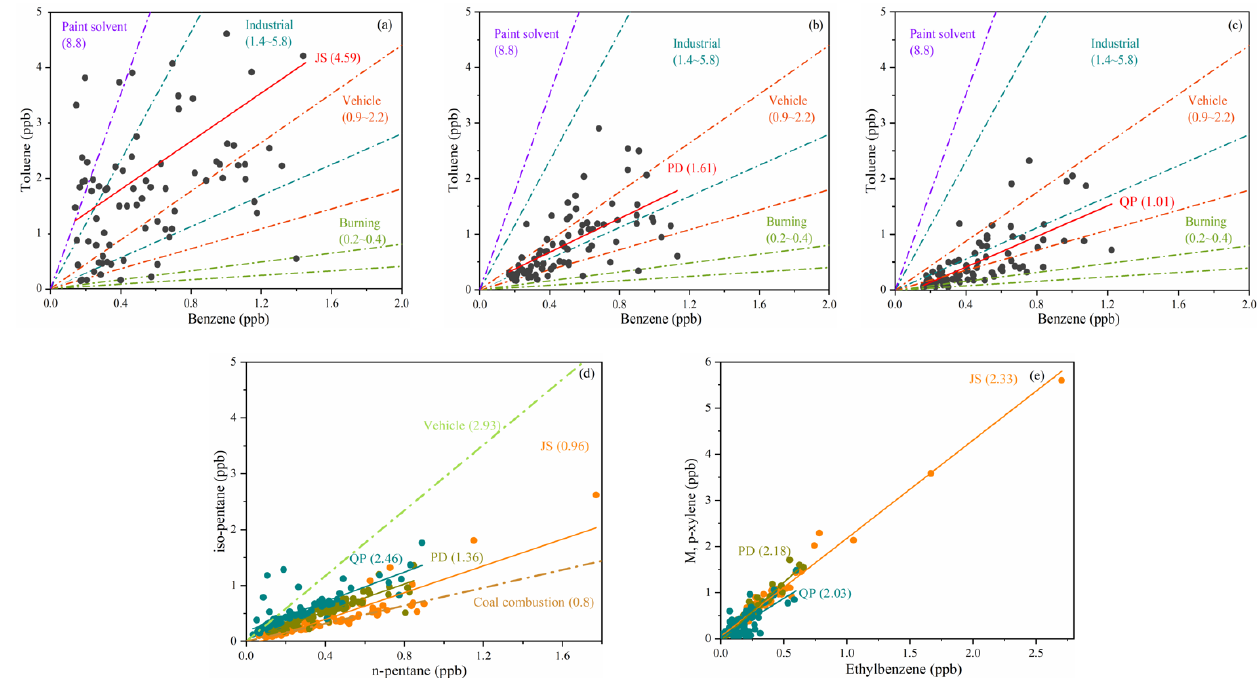
Figure 5. Specific ratios of the target VOC species for the source identification. The linear correlations between toluene and benzene at the (a) JS, (b) PD and (c) QP sites and (d) m − ,p -xylene and ethylbenzene and (e) iso -pentane and n -pentane at JS (orange), PD (yellow) and QP